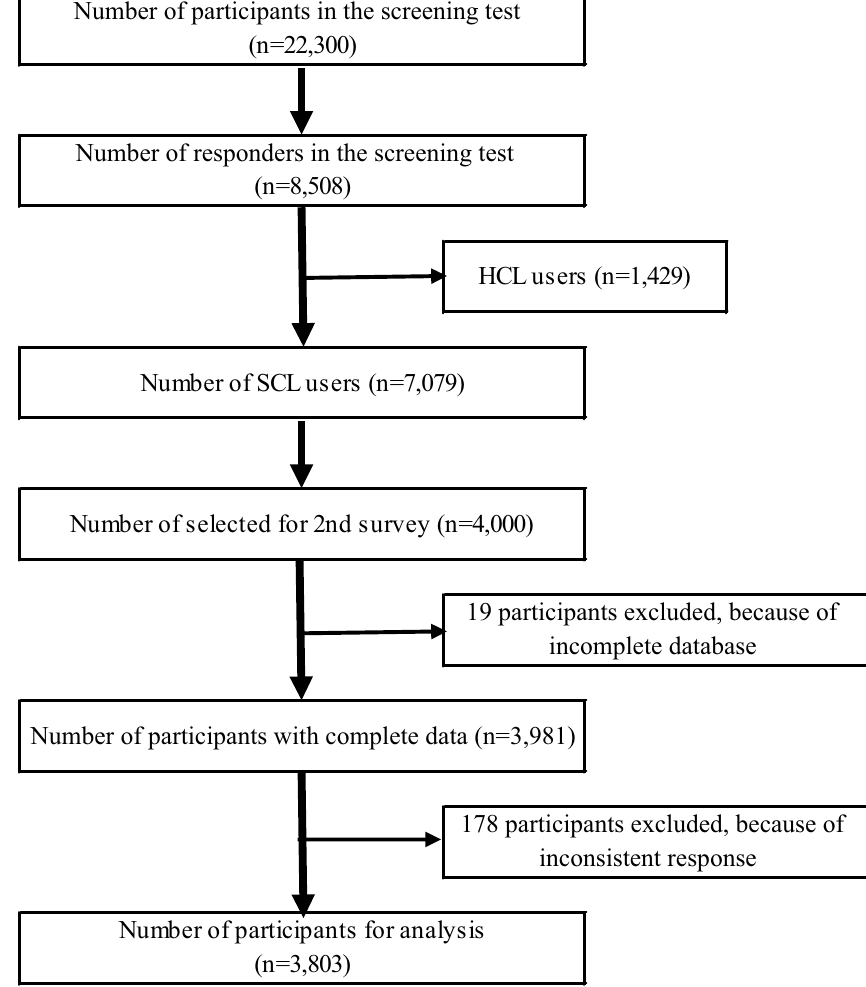
Figure 1. Flow diagram of study participants. HCL, hard contact lens; SCL, soft contact lens.